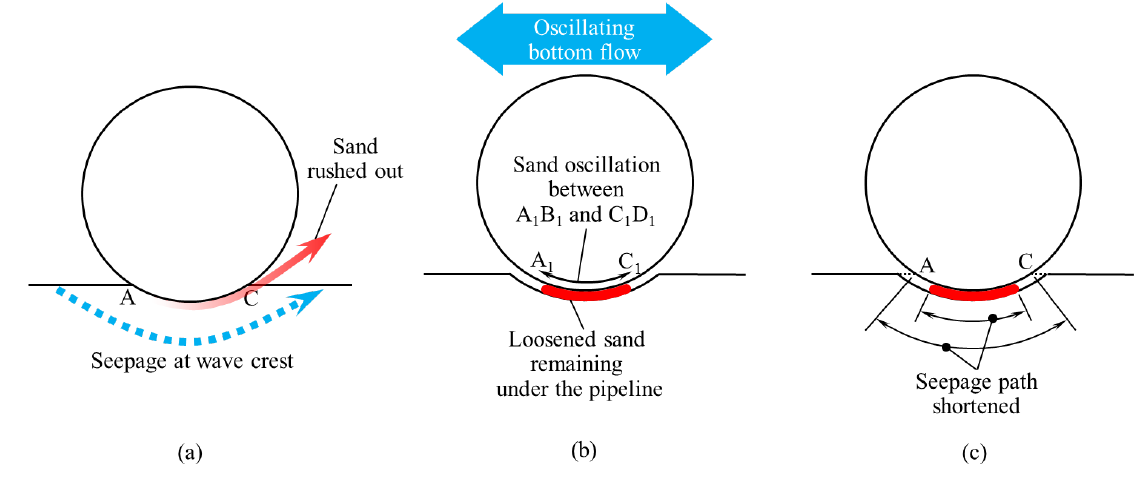
Figure 7. Illustration of the sand oscillation under the pipeline ( a ) sediment rushing out due to increasing oscillation amplitude; ( b ) remaining sediment oscillating almost symmetrically under the pipeline; ( c ) shortened seepage path due the loss of sediment.